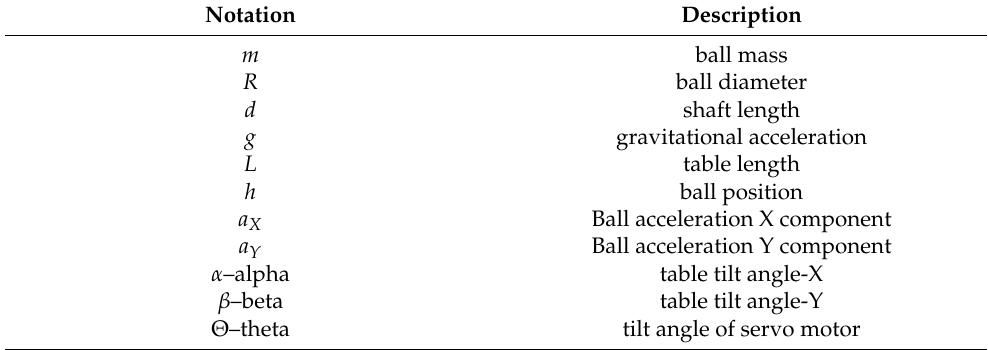
Table 1. Table 1. Notations.